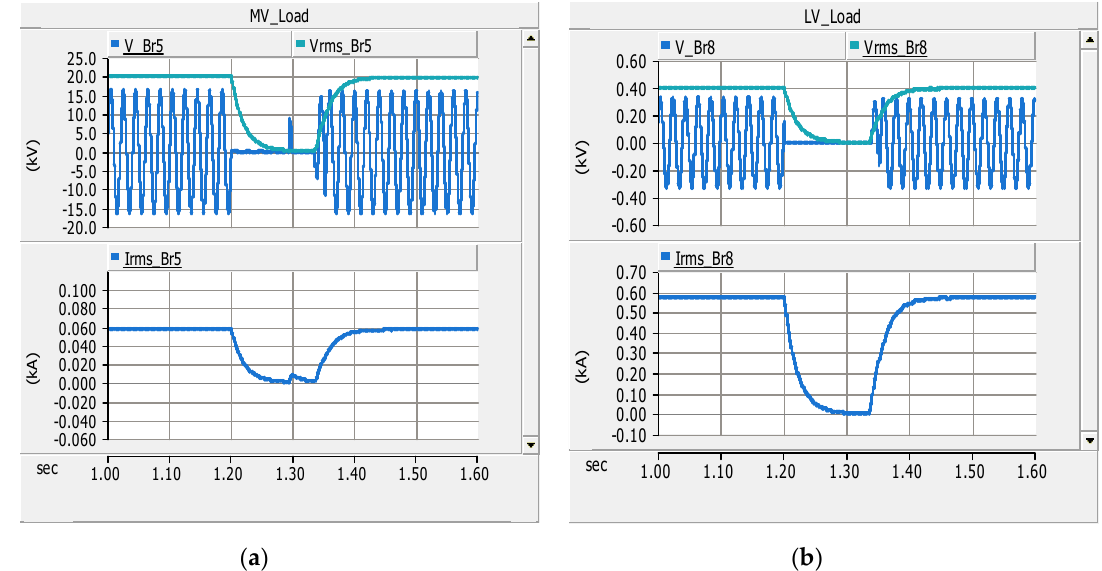
Figure 17. Three-phase RMS voltage and current and single-phase instantaneous voltage at loads before, during and after fault F1: ( a ) MV load and ( b ) LV load.